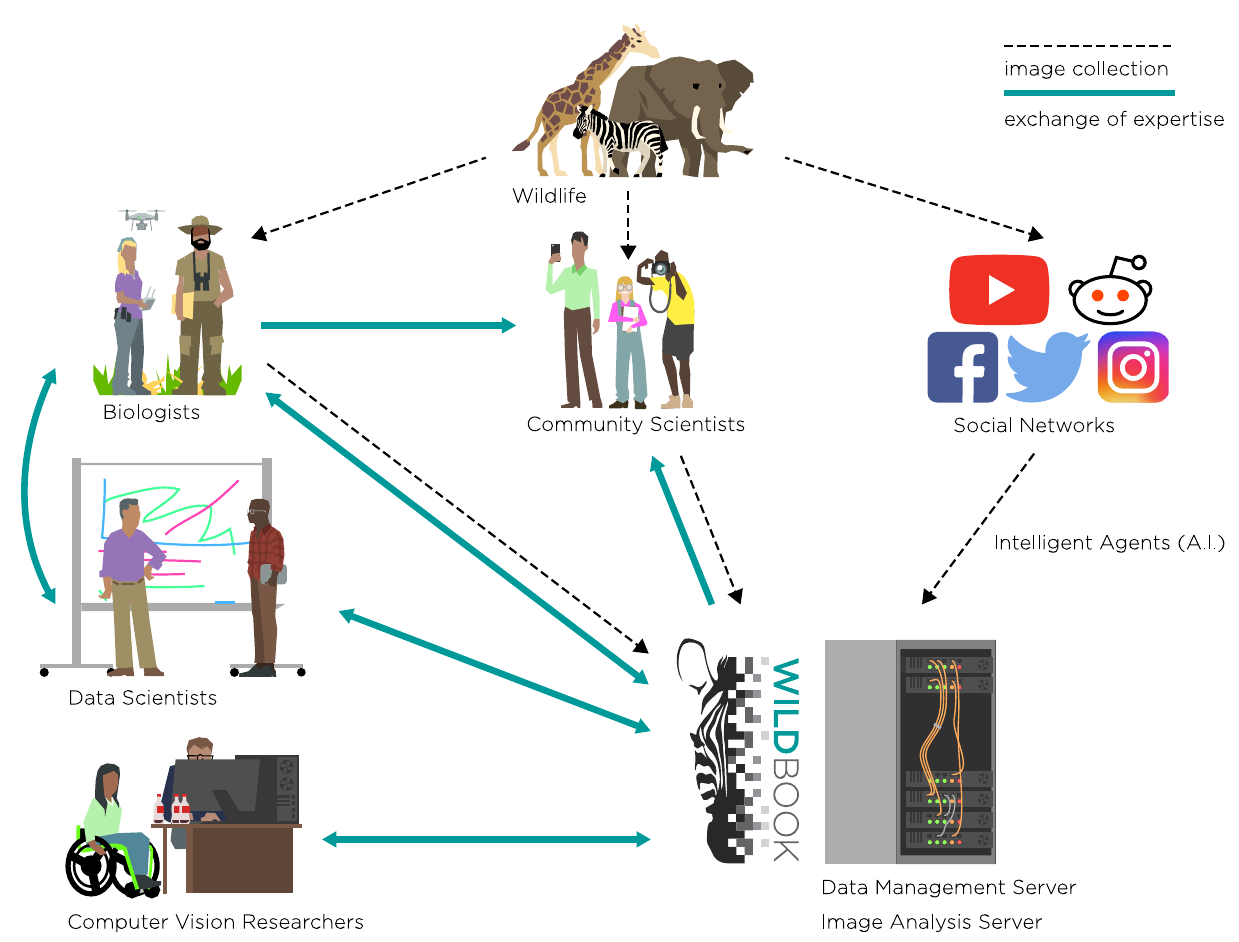
Box 1 | Wildbook: successes at the interface between community science and deep learning Wildbook, a project of the non-pro fi t Wild Me, is an open-source software platform that blends structured wildlife research with arti fi cial intelligence, community science, and computer vision to speed population analysis and develop new insights to help conservation (Fig. 4). Wildbook supports collaborative mark-recapture, molecular ecology, and social ecology studies, especially where community science and arti fi cial intelligence can help scale-up projects. The image analysis of Wildbook can start with images from any source — scientists, camera traps, drones, community scientists, or